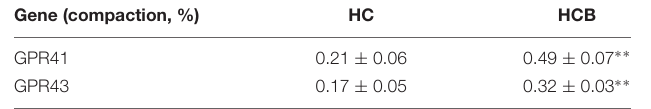
TABLE 2 | Ratio of DNA methylation of the GPR41/43 promoter in the cecum. Gene (methylation, %)